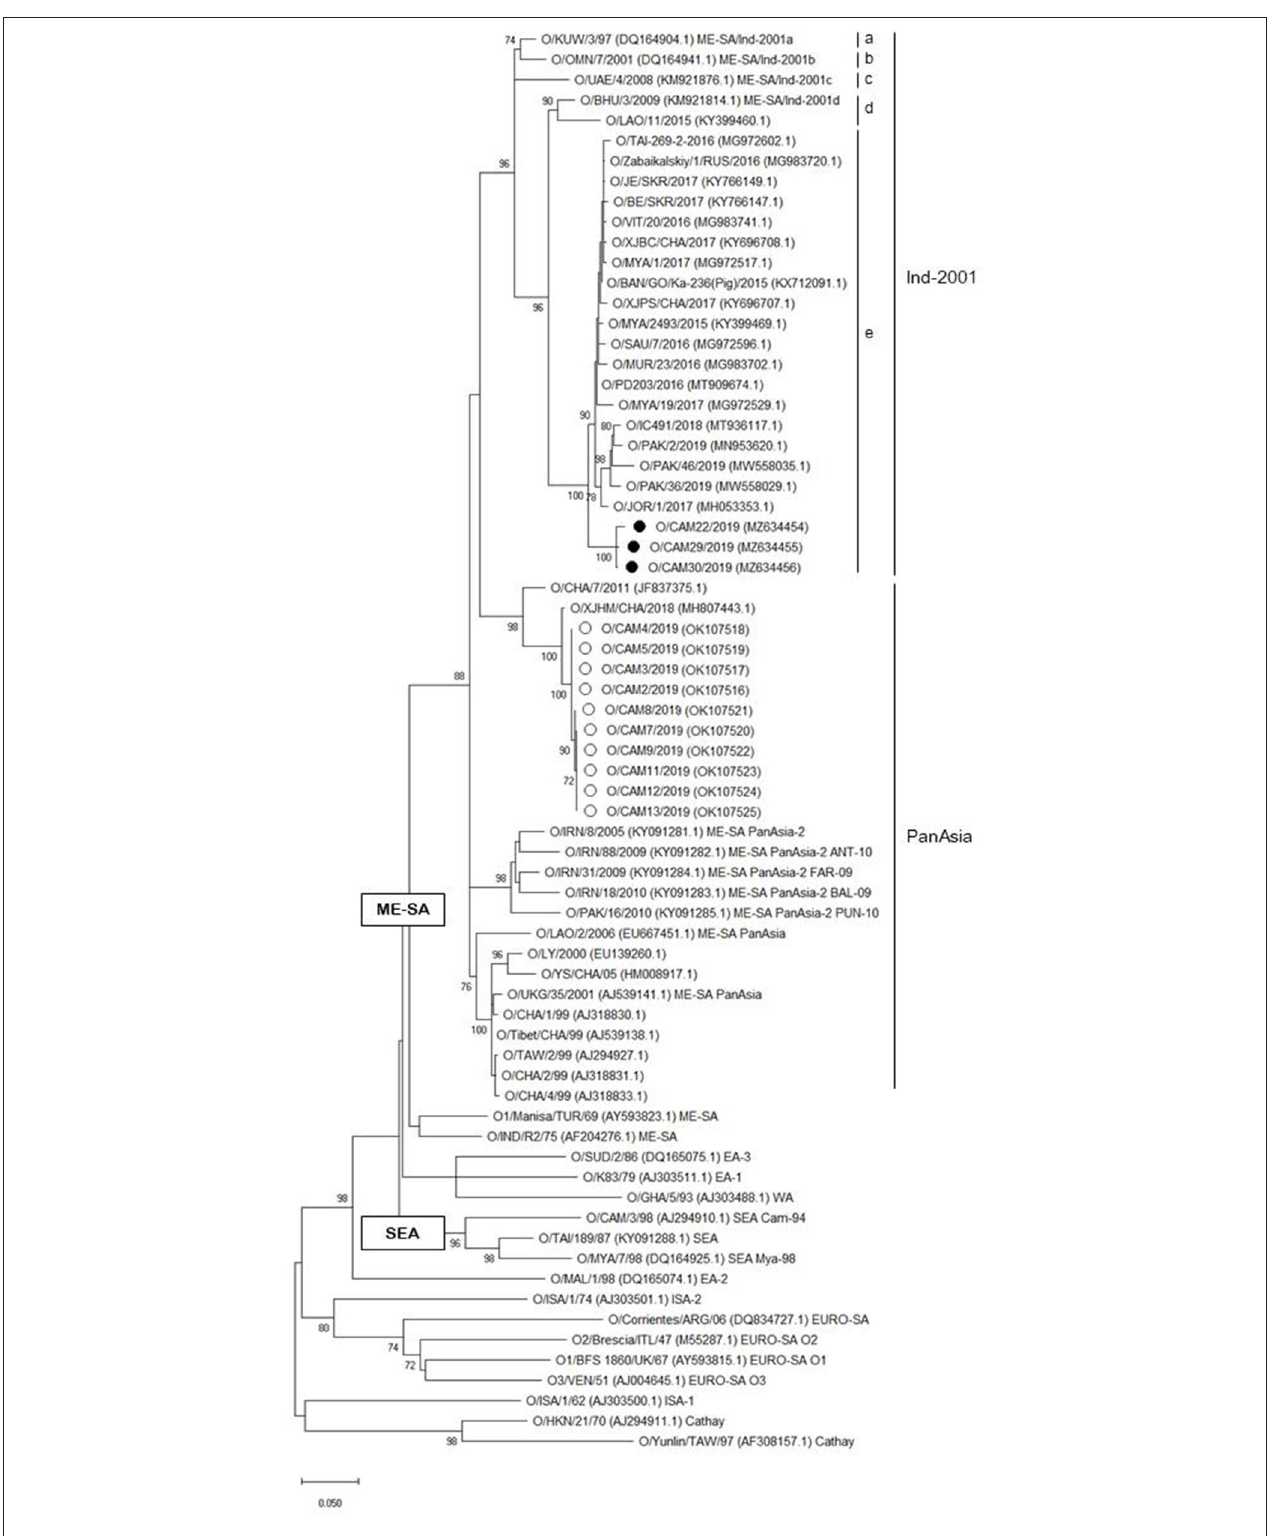
FIGURE 1 | Maximum likelihood tree showing the relationship of the VP1 coding sequence of O/ME-SA/Ind-2001e (black filled circle) and O/ME-SA/PanAsia (open circle) from Cambodia to other FMD type O viruses. The percentages of replicate trees in which the associated taxa clustered together in the bootstrap test (1,000 replicates) are shown next to the